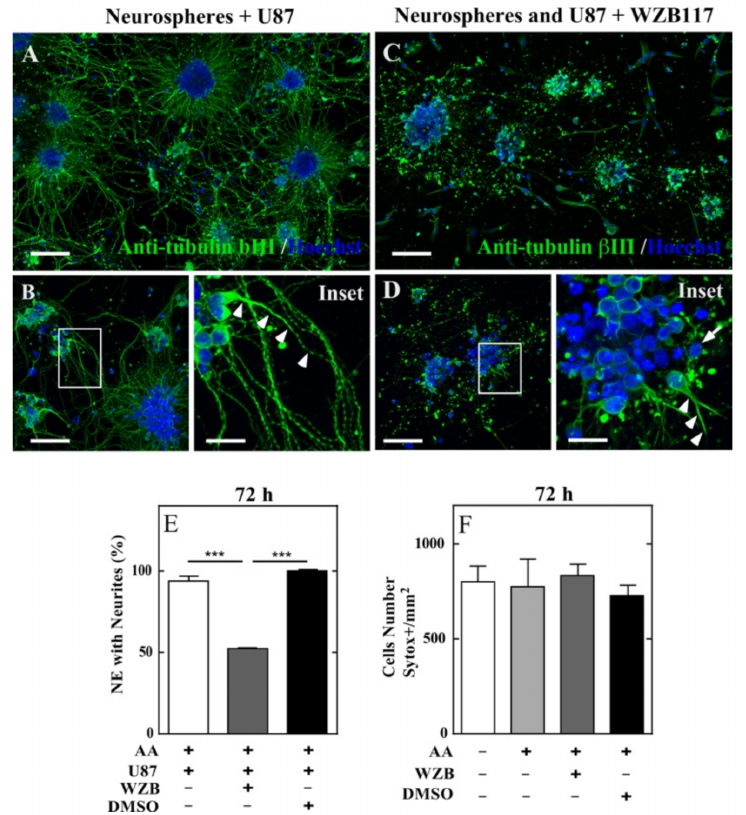
Figure 5. Co-culture of neurosp heres and U87 cells, generation of neurites and effect of the GLUT1 inhibitor, WZB117, on DHA recycling and neurite outgrowth. ( A – D ) Immunocytochemical analysis using anti- β III tubulin (green) and Hoechst for nuclear staining (blue). ( A ) neurospheres and U87 co-cultured cells treated with 100 µ M AA for 72 h. ( B ) Magnified image, highlighting the presence of long neuritic processes (Inset). ( C ) Neurospheres and U87 co-cultured cells treated with 100 µ M AA for 72 h and incubated with 5 µ M WZB117 for 24 and 48 h. ( D ). Magnified image, where short neuritic processes (Inset, arrow heads) or their absence (Inset, long arrow) were observed. ( E ) Quantification of the percentage of neurospheres with neurites, treated with WZB117 or incubated with DMSO. ( F ) SytoxGreen detection by IncuCyte ® analysis to determine cell viability ( n = 3). Scale bar; 20 µ m. Statistical analysis ANOVA, followed by Tukey posttest. *** p < 0.001. Bar graphs represent mean + SEM. In total, 45–50 neurospheres were quantified by condition. Scale bars, in ( A , C ), 200 µ m; in ( B , D ), 50 µ m; in insets, 20 µ